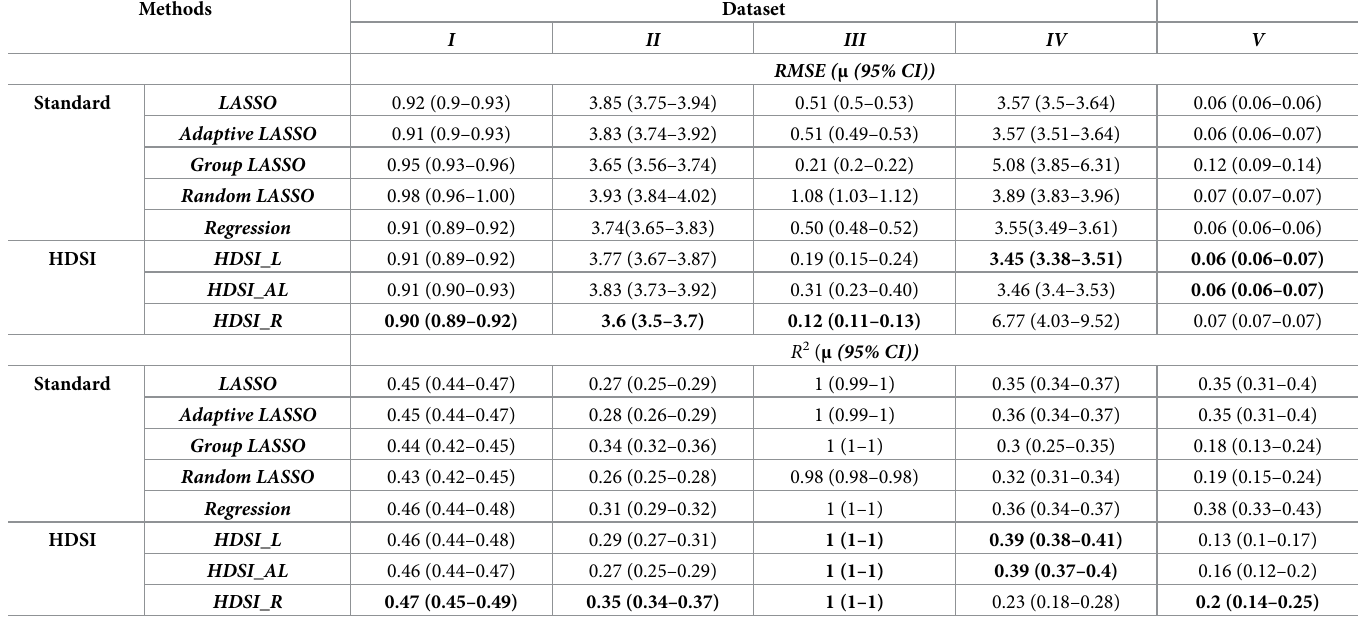
Table 8. RMSE performance of different methods on the real datasets for test